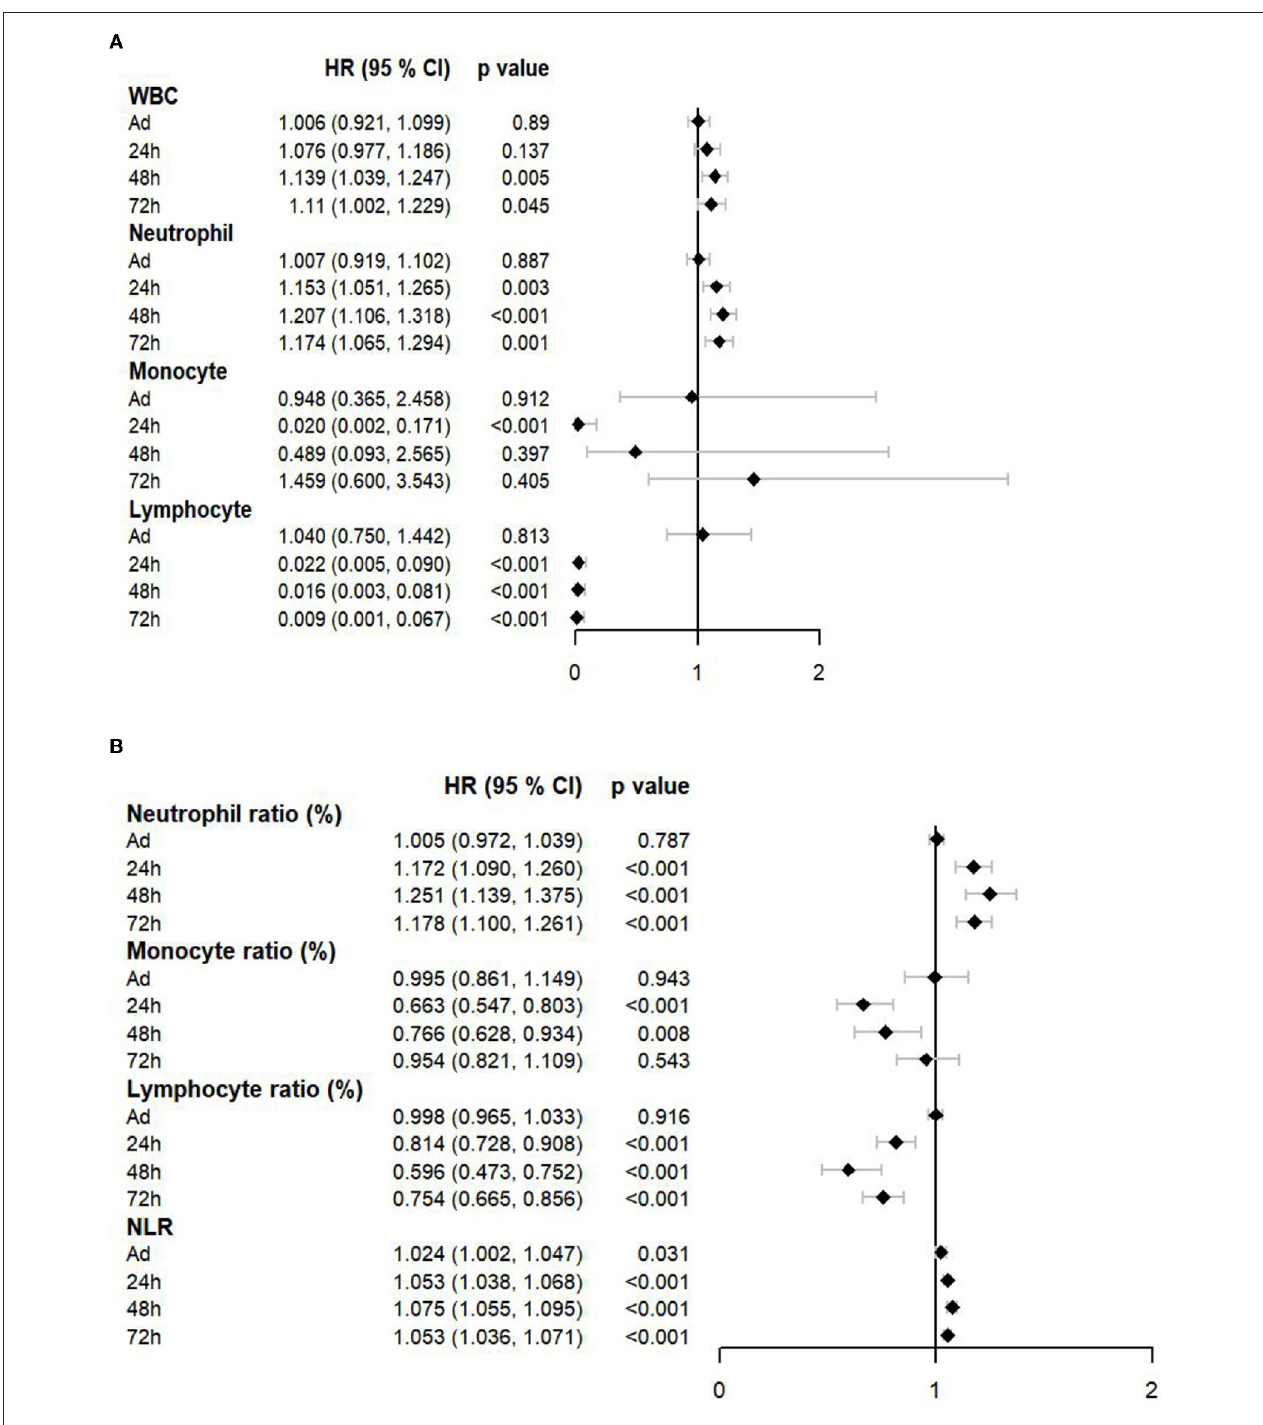
FIGURE 3 | A forest plot showed the effects of immune cell counts (A) and a ratio (B) on a prognosis of patients with EHS. WBC, white blood cell; NLR, neutrophil to lymphocyte ratio; HR, hazard ratio.